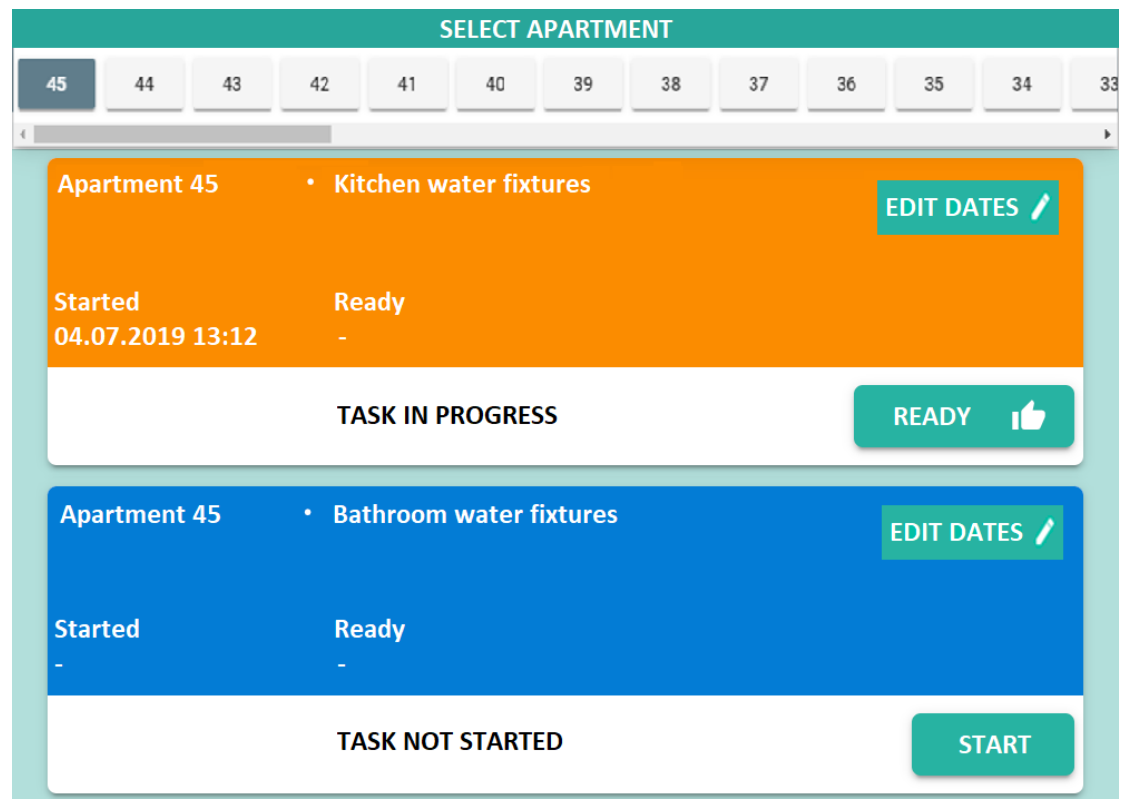
Figure 7. The digital monitoring application used in the case project, translated from Finnish to English [31].